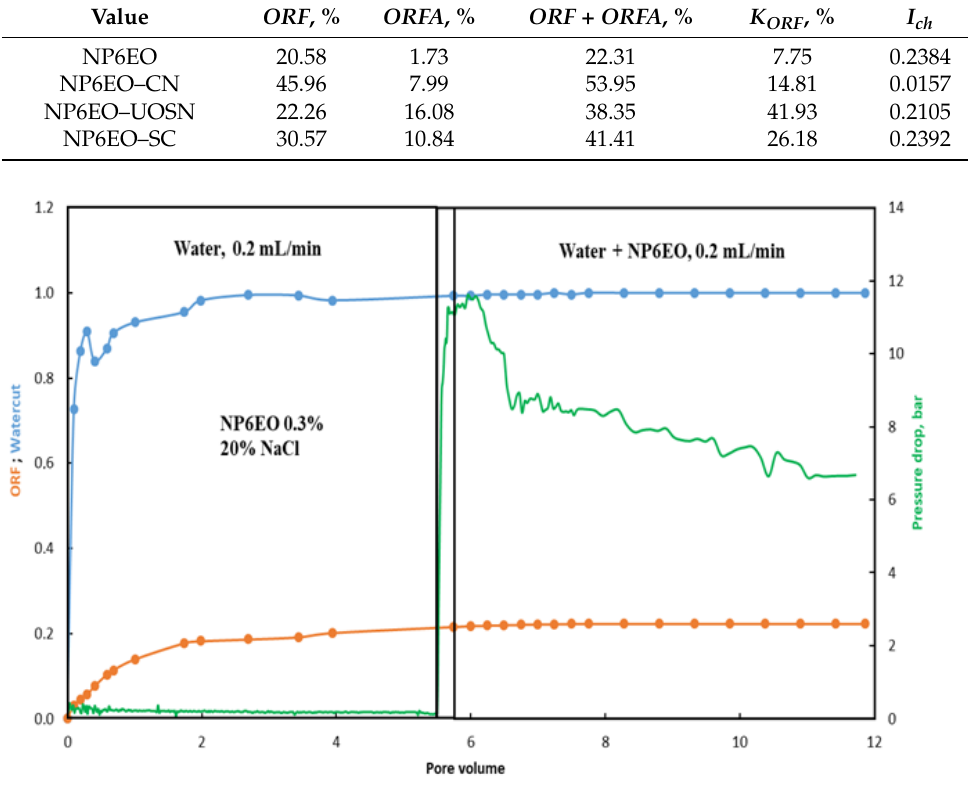
Figure 7. Oil displacement experiment of NP6EO flooding.